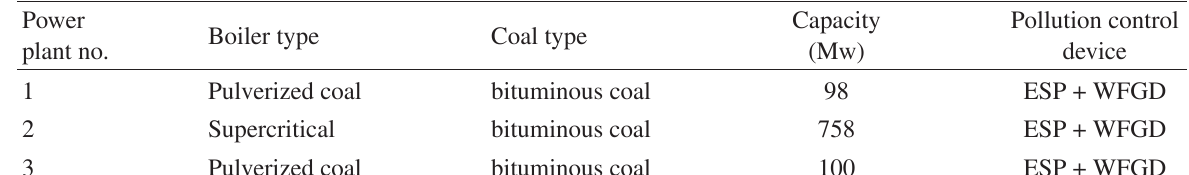
TABLE 2: Power plant configurations.